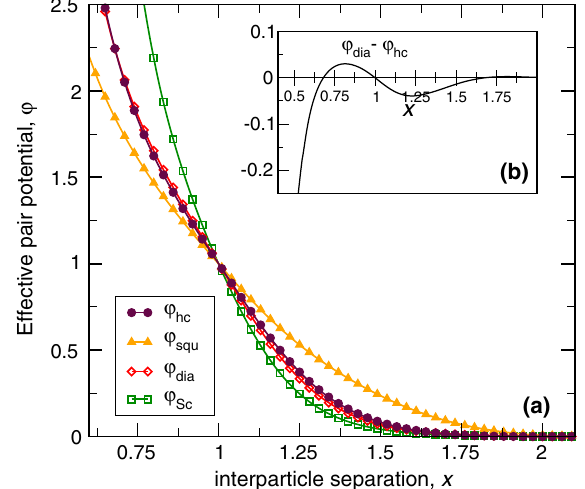
FIG. 1. Isotropic, convex-repulsive potentials, φ (described in the text), which maximize the density range of mechanically stable 2D honeycomb-and square-lattice ground states, respectively. Also shown are previously designed poten- tials, φ and φ [30], that maximize the density range of dia Sc mechanically stable 3D diamond-and simple cubic – lattice ground states, respectively. The inset highlights subtle differences between φ and φ . dia hc